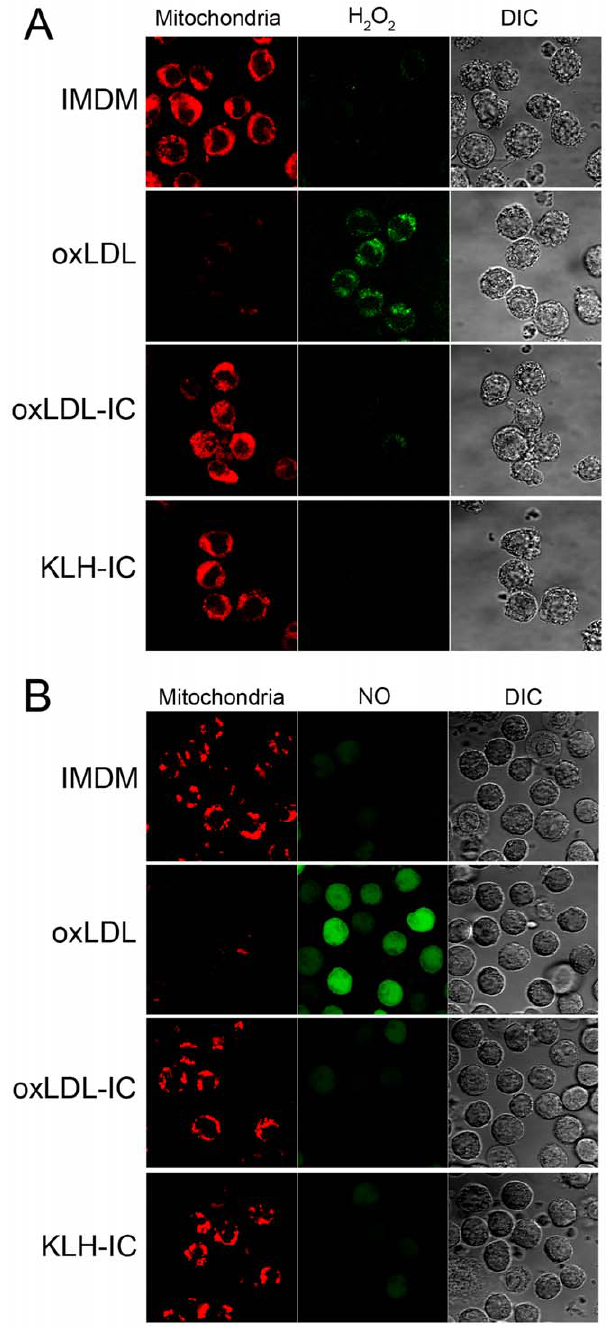
Figure 6. Differential effect of oxLDL and oxLDL-IC on mitochondrial membrane potential and ROS/RNS production. U937 cells were grown in phenol red-free IMDM supplemented with 10% fetal bovine serum, 100 units/ml penicillin, 50 m g/ml streptomycin, and IFN- c (200 ng/ml) for 18 h then treated with oxLDL (90 m g/ml), oxLDL-IC, KLH-IC (120 m g/ml) in IMDM up to 5 h. ( A ) Detection of H 2 O 2 : Cells were treated with CM-H2DCFDA (5 m M), and Mito Tracker (100 nM) for 30 and 15 min, respectively, prior to conclusion of incubation time with the treatments (5 h). Cells were fixed, suspended in sealed capillaries and visualized using Zeiss LSM 510 Laser scanning confocal microscope. ( B ) Detection of NO: IFN- c -treated cells were incubated with L-arginine (100 m M), and DAF-FM diacetate (10 m M) for 1 h, then washed with IMDM twice. Cells were then treated with oxLDL, oxLDL-IC, and KLH-IC as indicated above. Mito Tracker (100 nM)